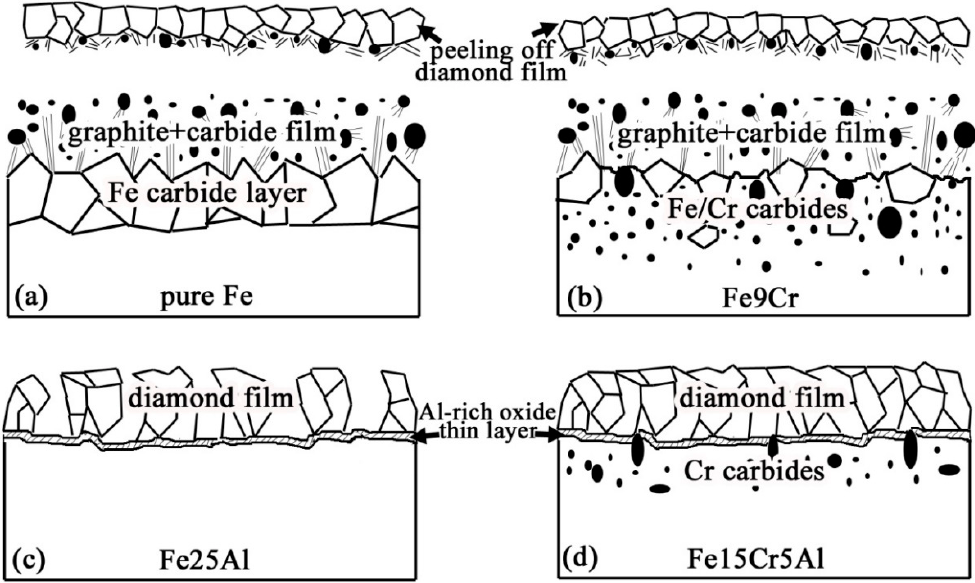
Figure 7. Model describing the mechanism of diamond films grown on Al, Cr-modified Fe-based substrate is proposed. (Reproduced with permission from [52]).